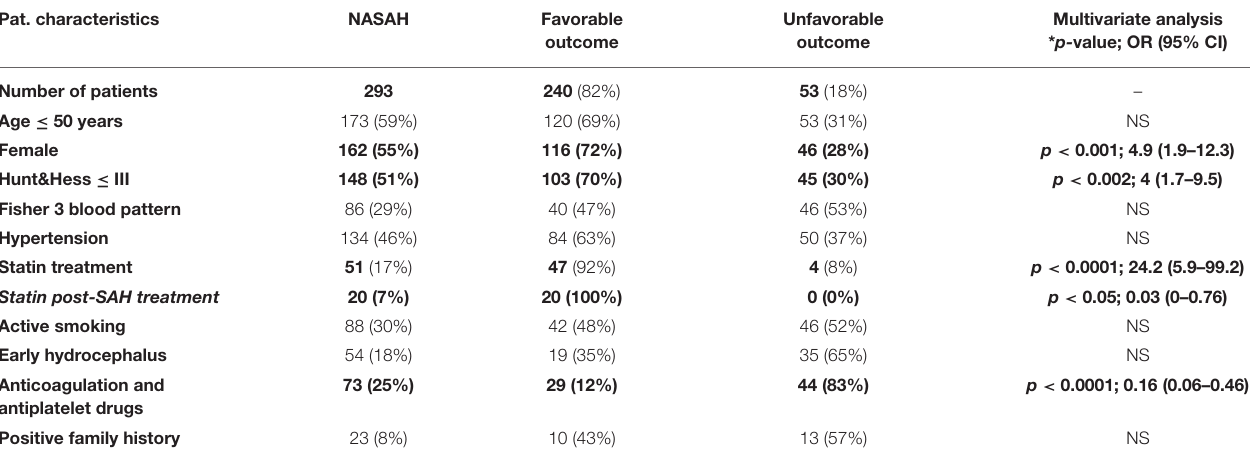
TABLE 3 | Clinical outcome in association with patient characteristics in NASAH patients admitted to the University Hospital (City) between 1999 and 2018. Pat.